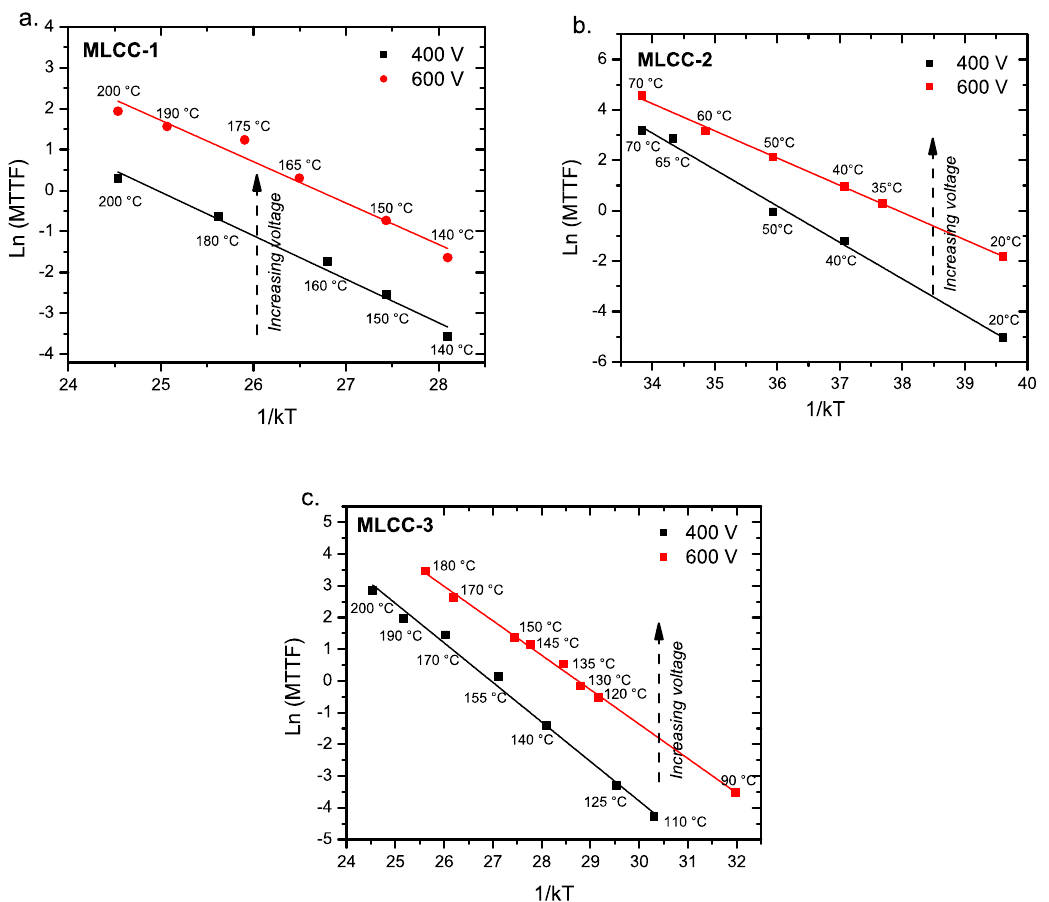
Figure 11. Characteristic life according to the Arrhenius model for ( a ) MLCC-1, ( b ) MLCC-2, and ( c ) MLCC-3, according to the electrical and thermal stress. Solid lines represent the best fits given by Equation (5).